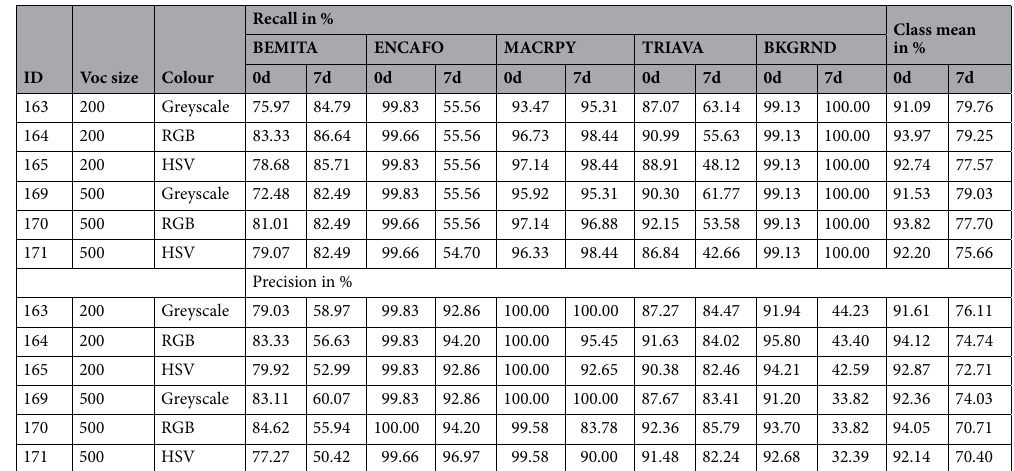
Table 1. Recall and precision of the different models trained by k-d tree SVM-quantizer and SGD solver for different dictionary sizes (vocsize) and colour spaces (colour) based on the Lab0d und Lab7d datasets. TRIAVA, T. vaporariorum ; BEMITA, B. tabaci ; ENCAFO, E. Formosa ; MACRPY, M. pygmaeus ; BKGRND, Background; ID, Model ID.